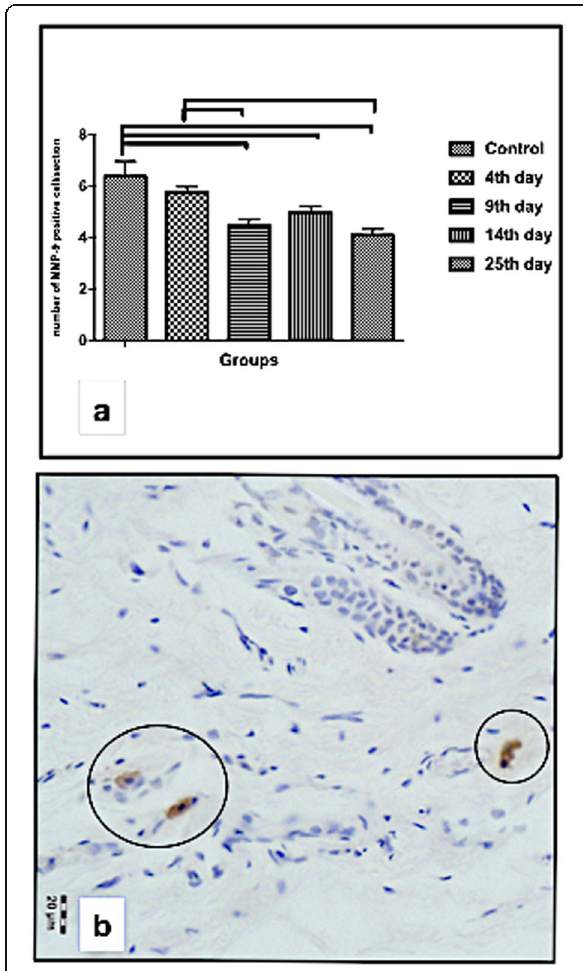
Fig. 5 Number of metalloproteinase 9 (MMP-9)-positive cells per section in the dermis ( a ) and a representative image showing the immunostaining for (MMP-9) in the cytoplasm of the cells of the dermis of the control group (circles in b